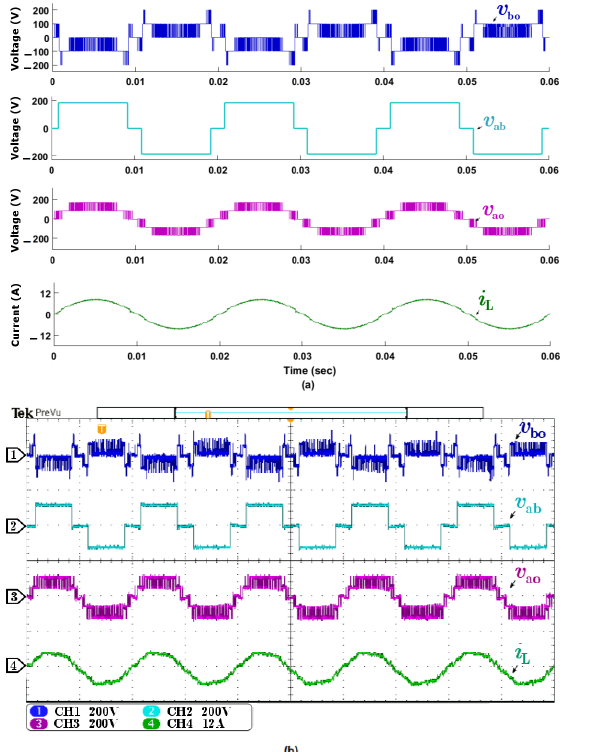
Figure 11. Output voltage of inverter topology for load-A at M = 0.9, ( a ) simulation waveform of respective converter modules and inverter current, ( b ) experimental waveform of respective converter modules and inverter current, traces channel 1, 2, 3 (200 V/div) and 4 (12